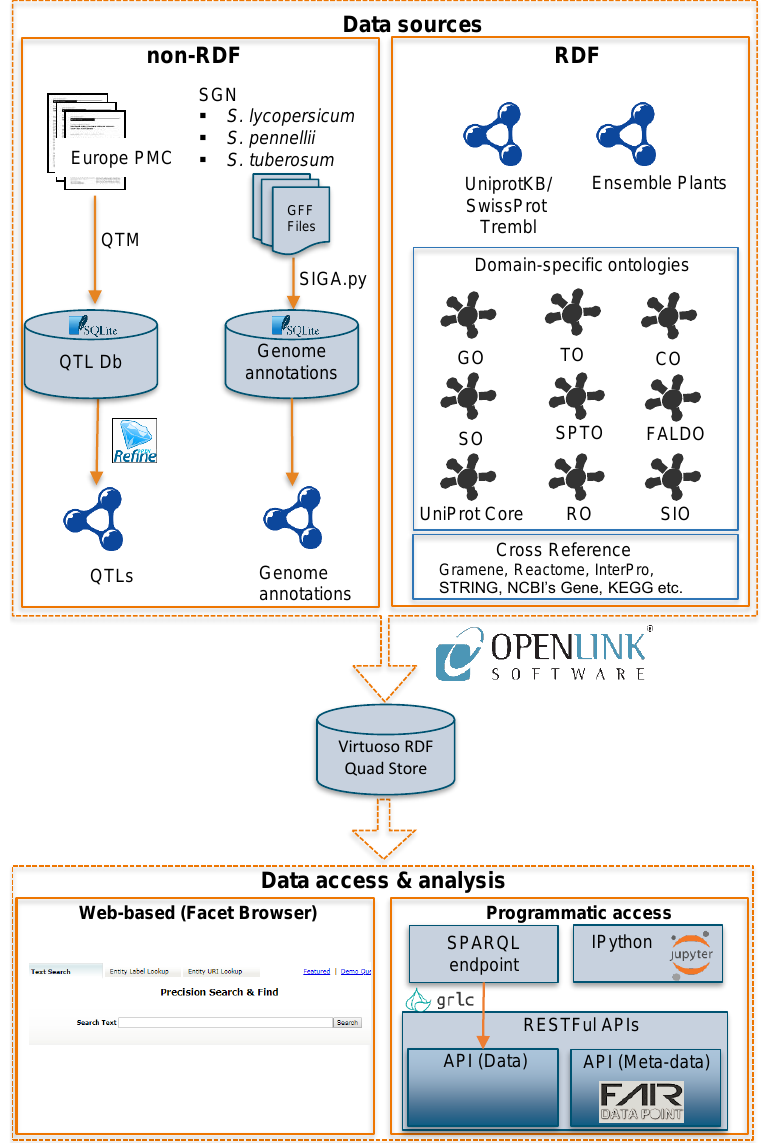
Figure 1. Data generation and ingestion pipeline. All data originate from either non-RDF or RDF sources. Several tools are used to retrieve and transform non-RDF data into RDF graphs: QTLTableMiner++ (QTM) [28] is used to extract tomato and potato quantitative trait loci (QTLs) from Europe PubMed Central (PMC) articles; OpenRefine [29] is used to transform the QTLs into RDF according to the specified data model. Similarly, SIGA.py tool [30] converts the genome annotations, as provided by the Sol Genomics Network (SGN) in GFF files into RDF graphs with gene models and markers. In addition, the UniProt (proteomes) and Ensembl Plants (gene models) distribute their data in RDF format. All RDF graphs including domain-specific ontologies (in OWL) and database cross-references were stored and integrated with Virtuoso RDF Quad Store. The resulting linked datasets are made available for queries and analyses through data-access layer: (i) Linked data browser, (ii) SPARQL endpoint, (iii) grlc-based Web API [31] and (iv) FAIR Data Point (FDP) metadata service